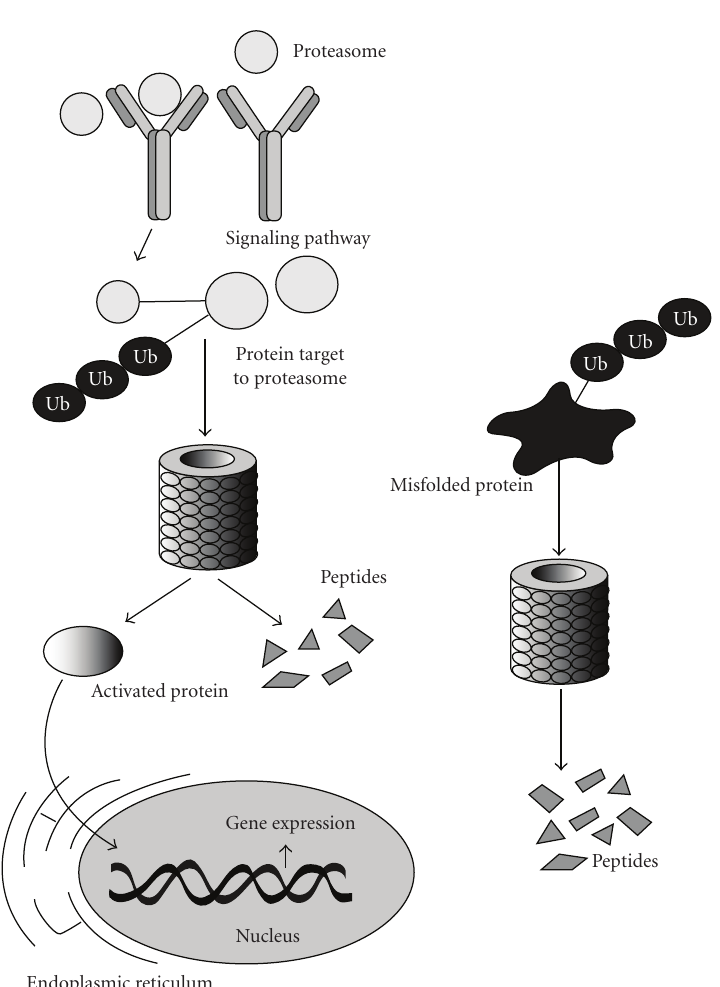
Figure 5: The Proteasome Signaling Pathway. Normally produced (left) or misfolded (right) proteins that are destined for 28S proteasome- mediated degradation are targeted for degradation either by phosphorylation (P) or after tagging with ubiquitin (Ub), via ubiquitin ligase [133]. In this pathway, a polyubiquitin protein chain becomes bound to the 28S proteasome providing a mechanism required for protein degradation. Nonphosphorylated or non-Ub-tagged proteins (i.e., “activated proteins”) can bypass the proteasome pathway and be transported to the